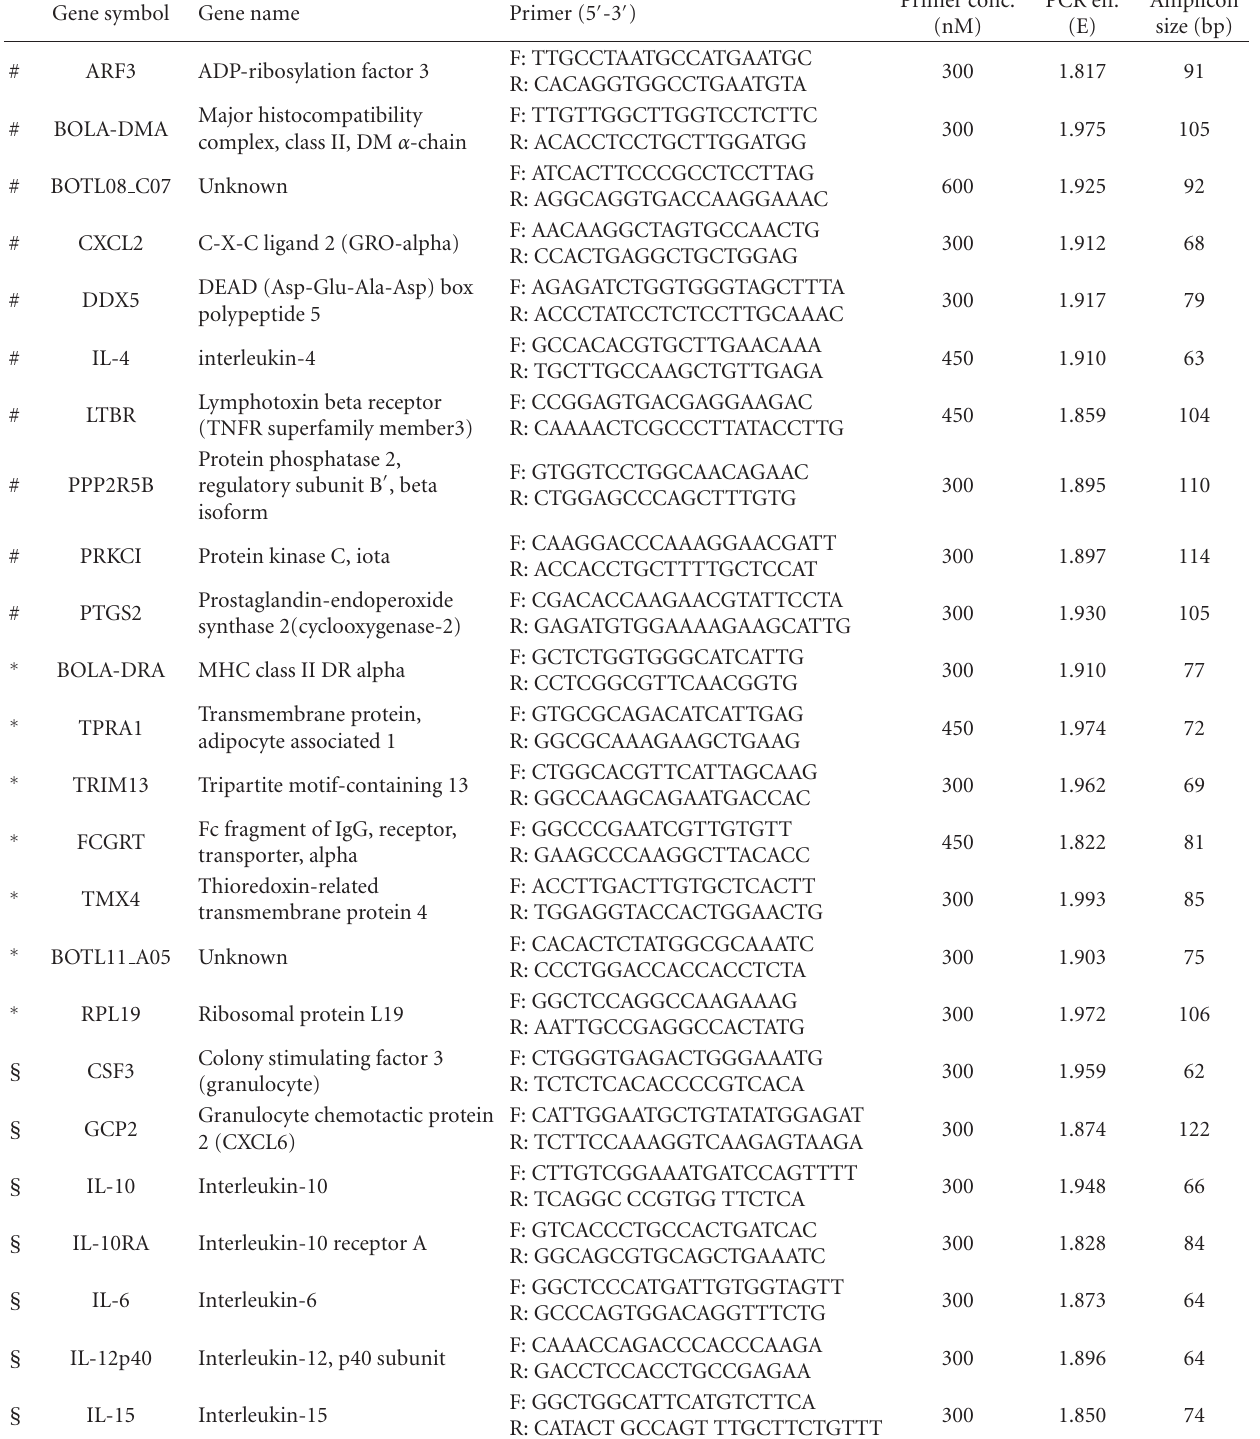
Table 1: Genes selected for qPCR analysis, the nucleic acid sequence and concentration (nM) of PCR primers for those genes (forward primer (F) and reverse primer (R)), the PCR e ffi ciency (E), and the PCR amplicon sizes